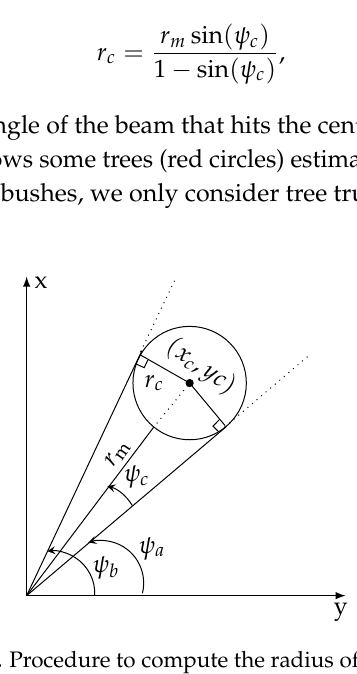
Figure 4. Procedure to compute the radius of tree